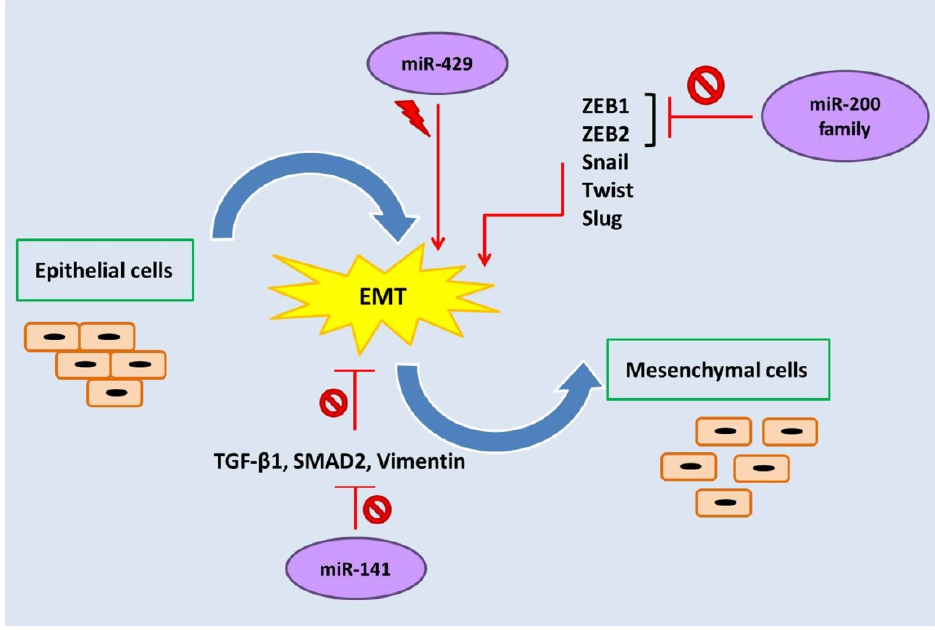
Figure 2. The miR-200 family regulates epithelial-mesenchymal transition (EMT).